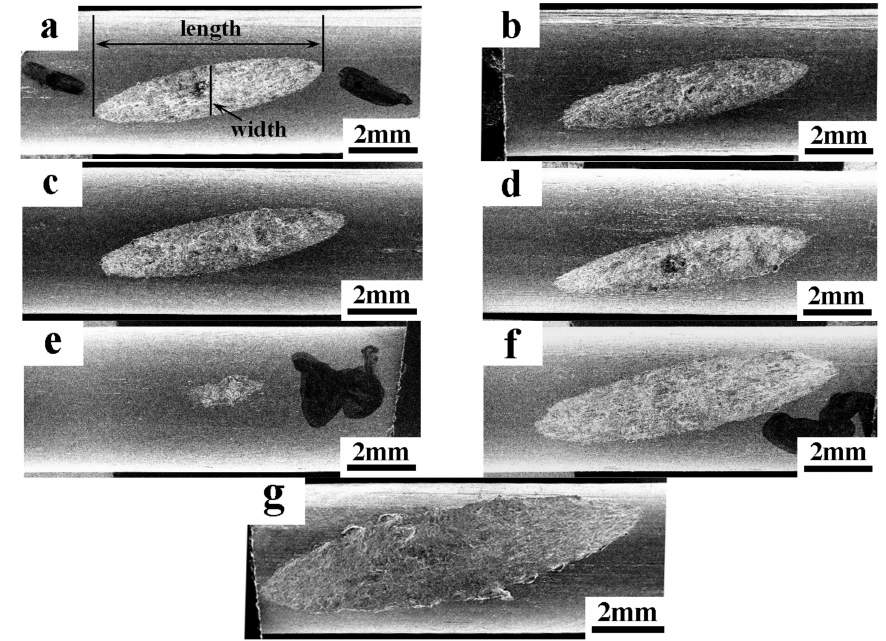
Figure 5. SEM overview of the contact scar on the Al wires: ( a ) F n = 10 N, D = ± 150 µ m, dry friction; ( b ) F n = 20 N, D = ± 150 µ m, dry friction; ( c ) F n = 30 N, D = ± 150 µ m, dry friction; ( d ) F n = 50 N, D = ± 150 µ m, dry friction; ( e ) F n = 30 N, D = ± 50 µ m, dry friction; ( f ) F n = 30 N, D = ± 250 µ m, dry friction; ( g ) F n = 30 N, D = ± 150 µ m, NaCl